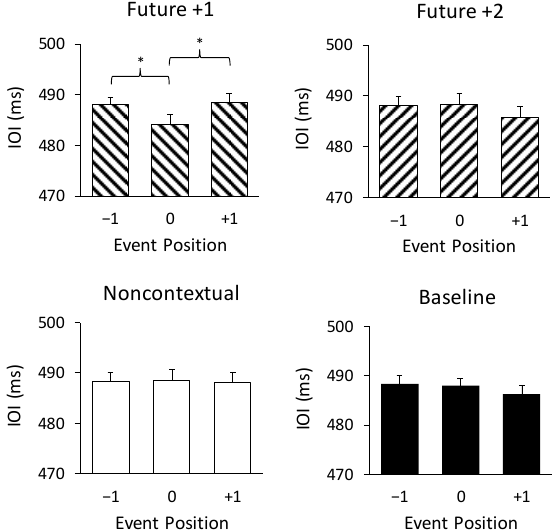
Figure 3. Pianists’ mean interonset intervals (IOIs) by altered feedback condition (baseline, future +1, future +2, and noncontextual) by target event position ( − 1, 0, +1). Error bars represent one standard error. * p < 0.05.